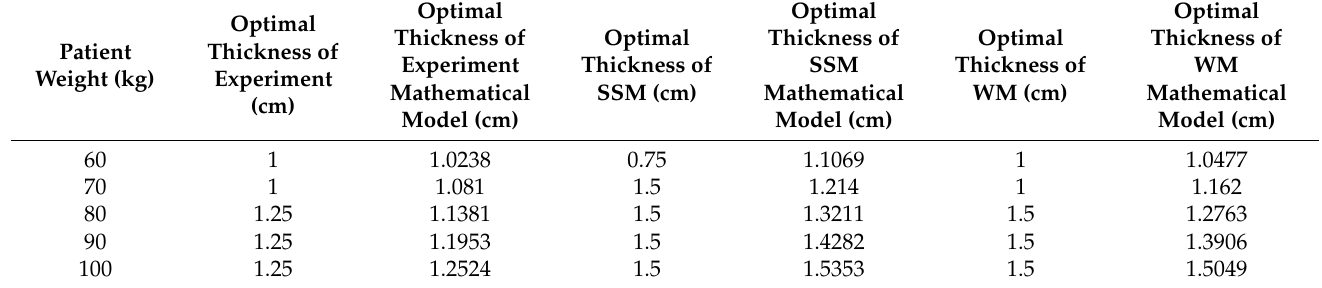
Table 4. Validation of plantar pressure from FEA.